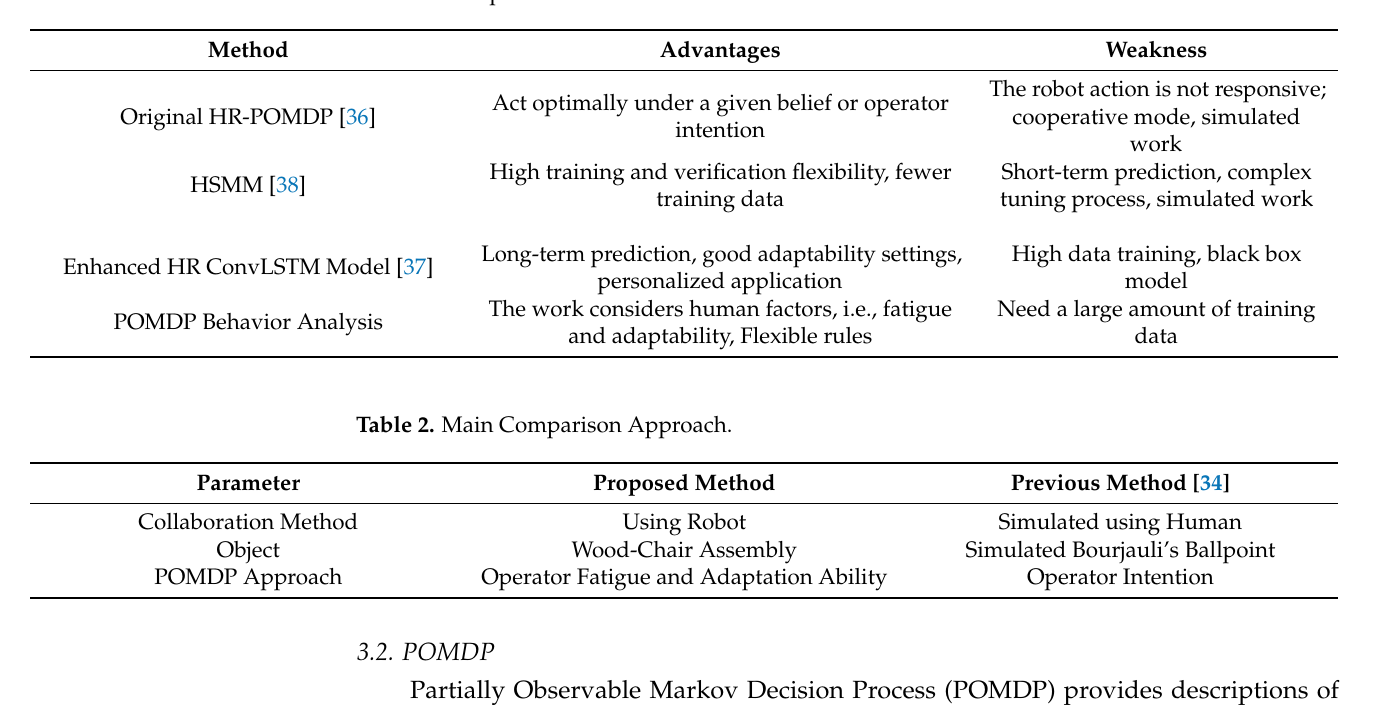
Table 1. Comparison with another model.